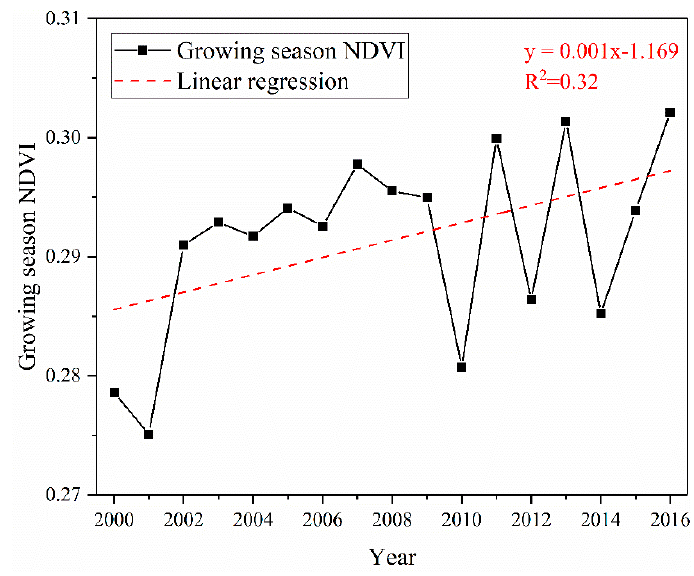
Figure 2. The inter-annual variation of growing season Normalized Difference Vegetation Index (NDVI) since 2000 in the YZR basin.